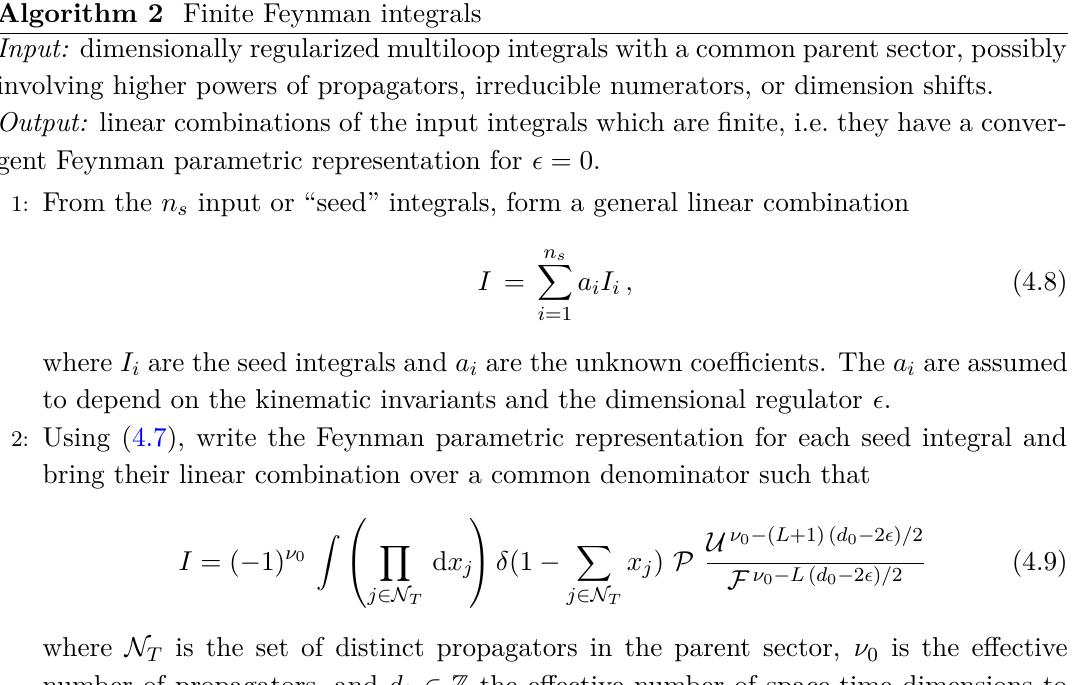
Algorithm 2 Finite Feynman